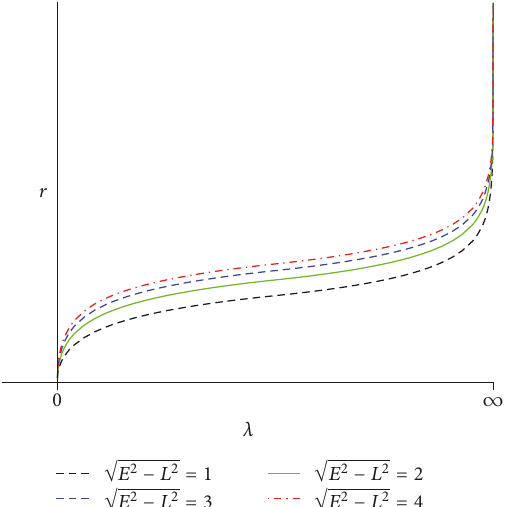
Figure 1: Null geodesics for different values of